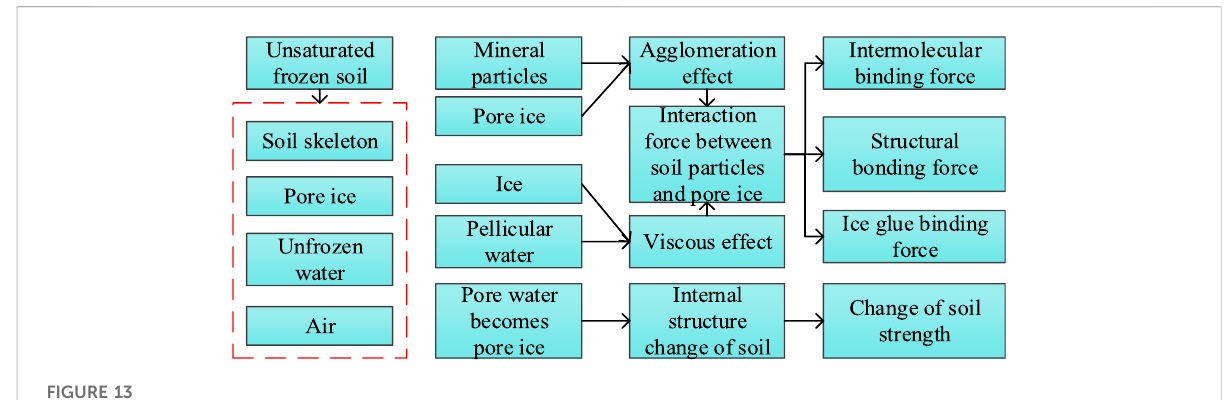
FIGURE 13 In fl uencing factors of soil particle and pore ice force.